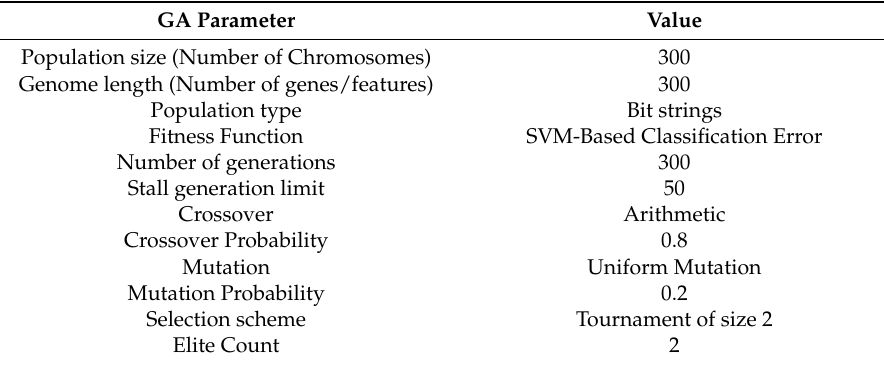
Table 1. Numerical values of different GA parameters considered in this study.